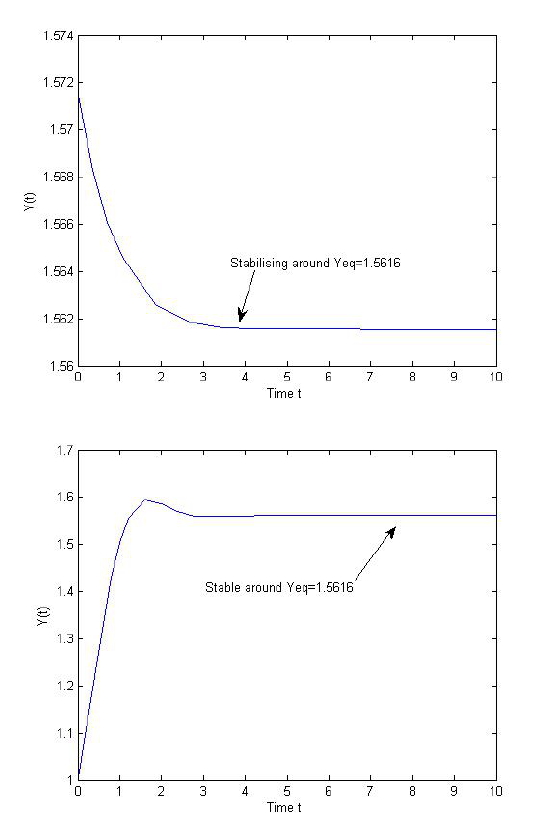
Fig. 2. The positive equilibrium is stable for τ = 0 and µ = 2 , top graph. The equilibrium still remains stable for τ = 0 . 4 ( τ < τ c = 0 . 55 ) and µ = 2 , bottom